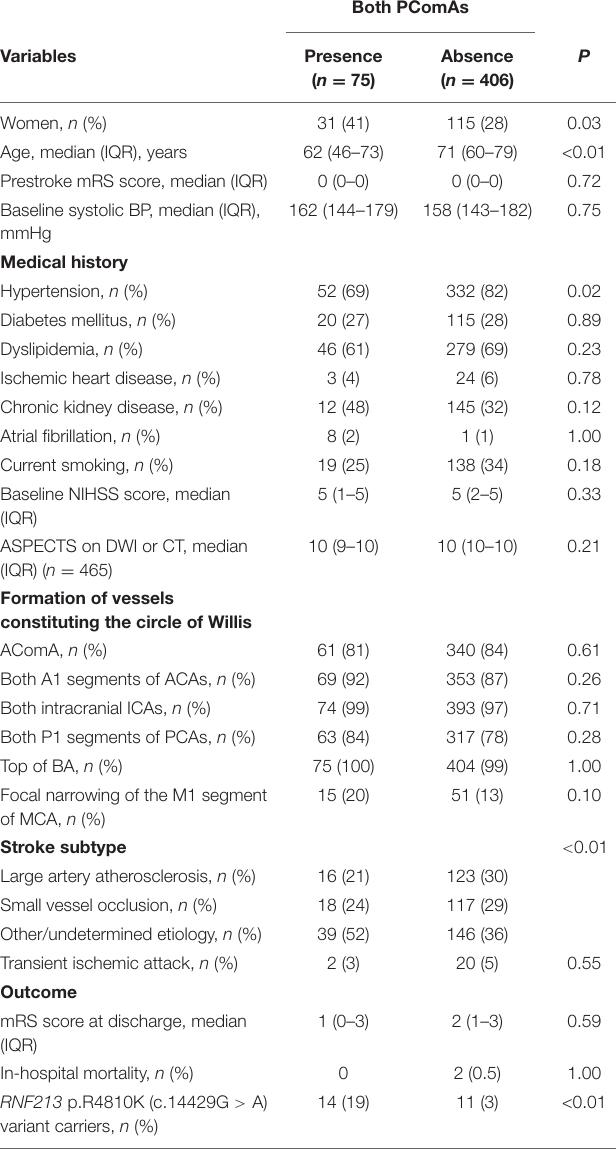
TABLE 2 | Baseline characteristics between patients with the presence and absence of both PComAs.